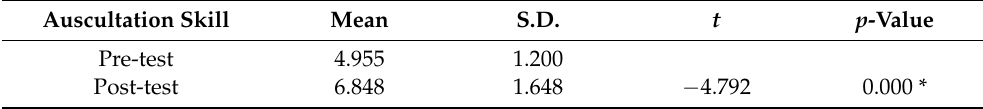
Table 5. The Independent t -test statistical results in pre- and post-tests of the experimental group. Auscultation